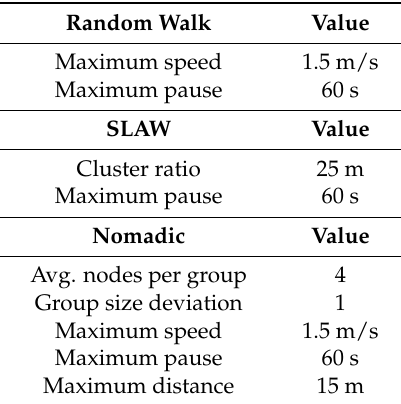
Table 3. Parameters of the mobility models of the nodes.